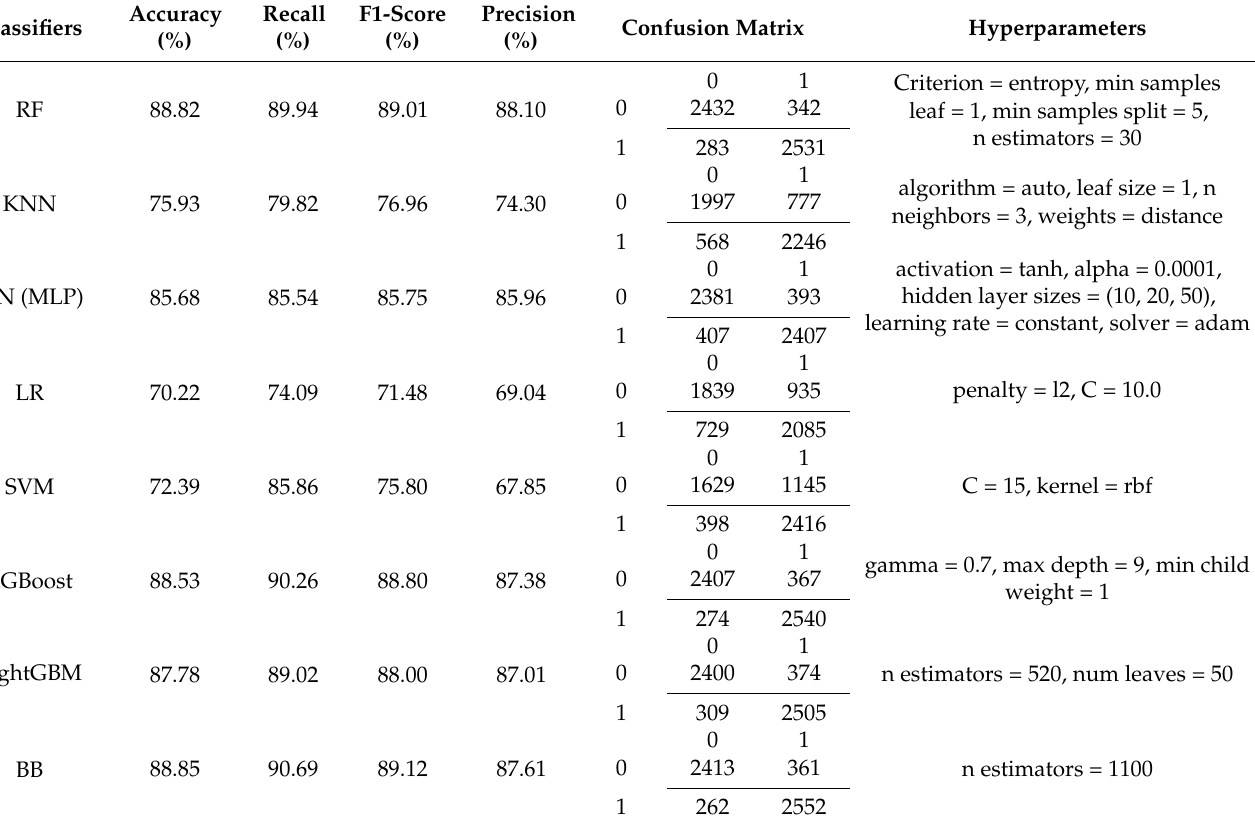
Table 3. Best metric scores of each ML model and the selected hyperparameters of each